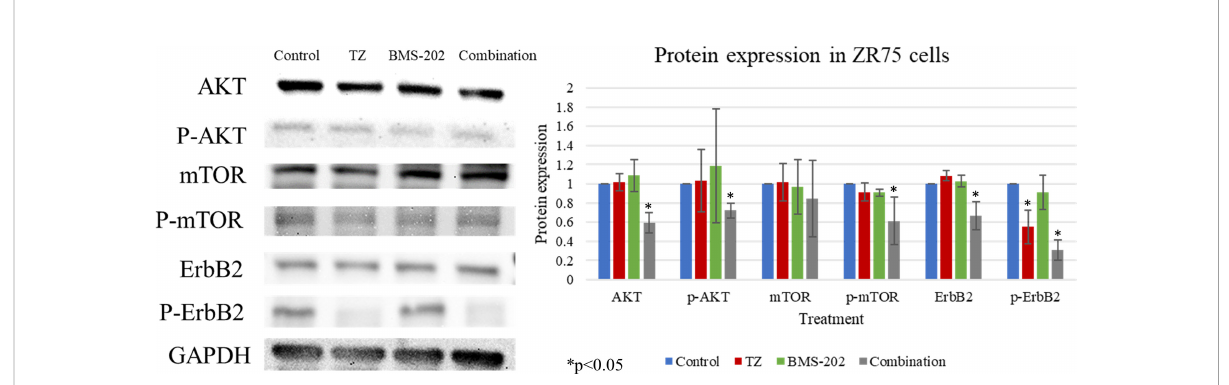
FIGURE 4 Western blot analysis of AKT, mTOR and ErbB2 in ZR75 cells under the effect of TZ and BMS-202. Treatment with both TZ and BMS-202 decreased the phosphorylation of ErbB2, AKT, and mTOR compared to individual treatment and untreated cells. GAPDH was used as a control for the amount of the loaded protein in this